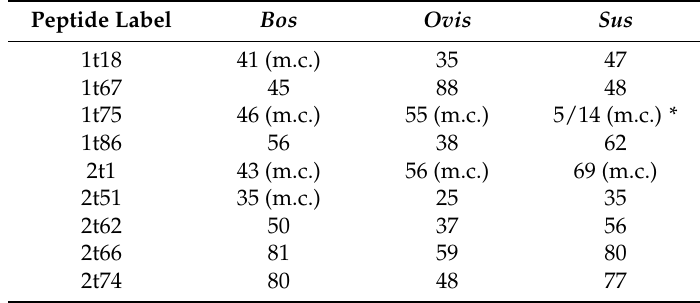
Table 3. Mascot ion scores for the nine unique peptides observed in all taxa (m.c. indicates only observed through missed cleavage site to the exception of * also included for similarity to homologous peptides).